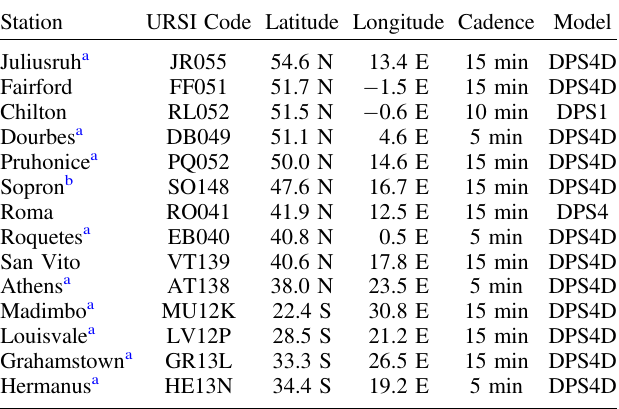
Fig. 1. Geographic locations of the Digisonde stations used for the HF-Int method in (a) Europe and (b) South Africa. Table 1. List of the Digisonde stations with International Union of Radio Science (URSI) codes, geodetic coordinates, cadence of measurements, and Digisonde